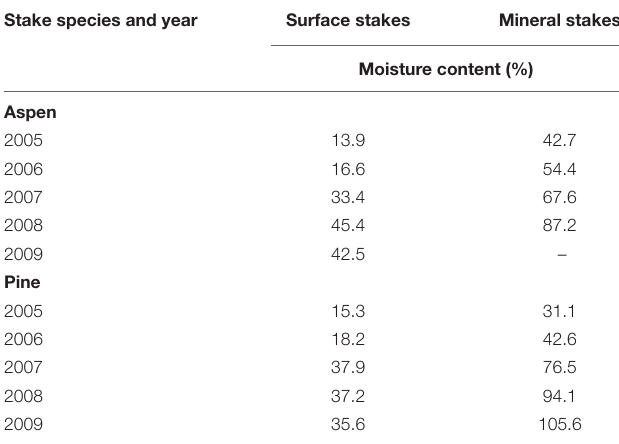
TABLE 4 | Water content of surface and mineral soil stakes with microbial decay after a hydromulch application on the Cedar Fire near Alpine, California. Stake species and